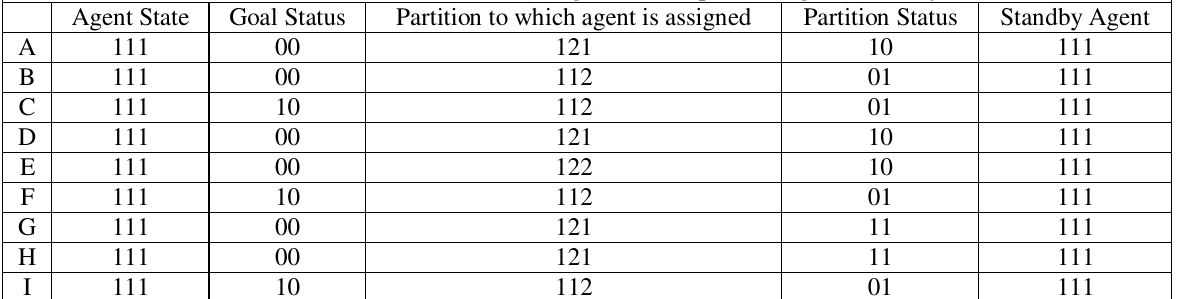
Table 4: States status of Leader Agent after implementing MDP